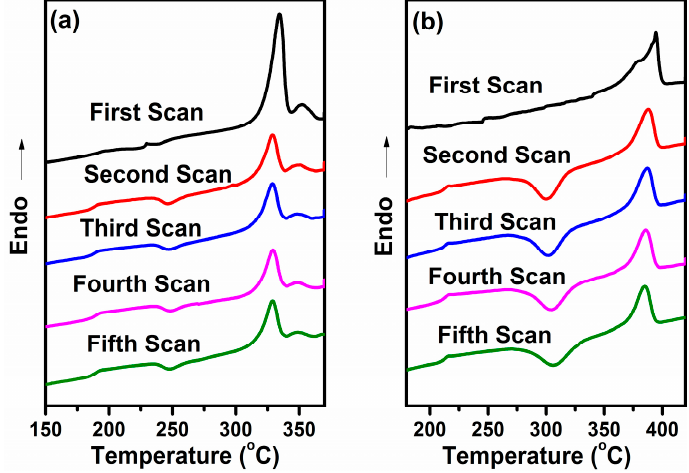
Figure 4. Repeatedly multiple DSC heating scans of ( a ) PI-1; ( b ) PI-2.